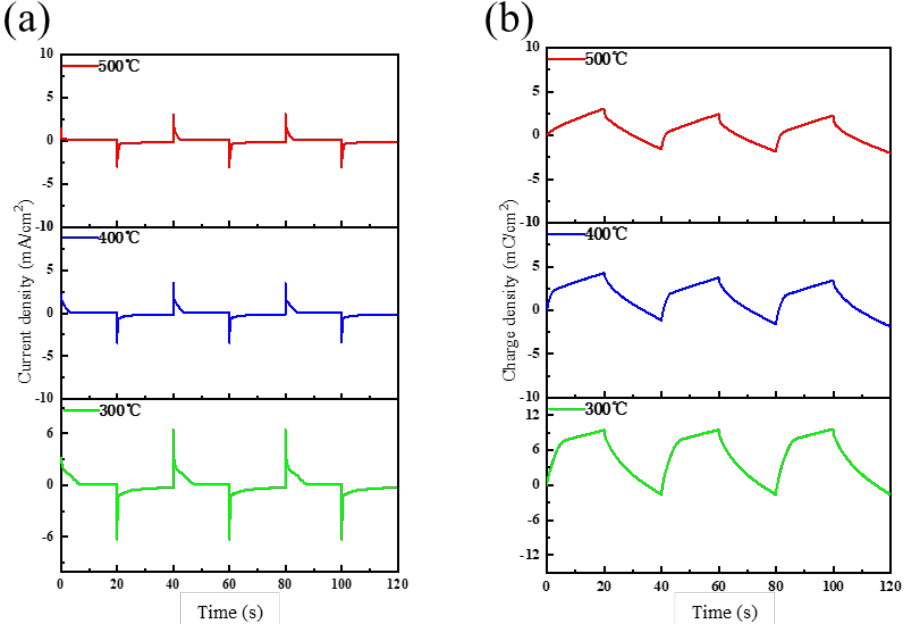
Figure 7. Current density curve ( a ) and charge density curve ( b ) of NiO films with different annealing